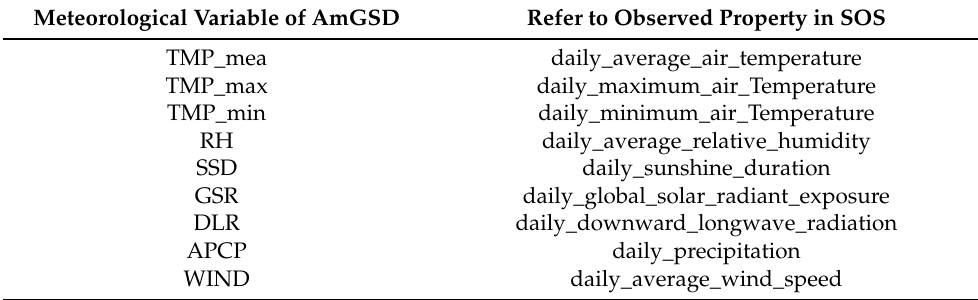
Table 2. Mapping the meteorological variable of AmGSD to observedProperty.